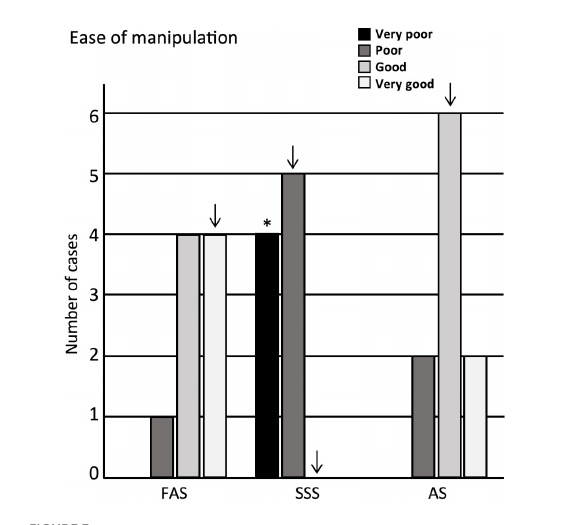
FIGURE3 Bar charts of the ease of manipulation. Very poor = 4 signs; poor = 3 signs; good = 1 or 2 signs; very good = no sign. Significance after Bonferroni correction: ∗ p < 0.05; ↓ = significant before Bonferroni correction; FAS, formaldehyde solution; SSS, salt-saturated solution; AS, alcohol